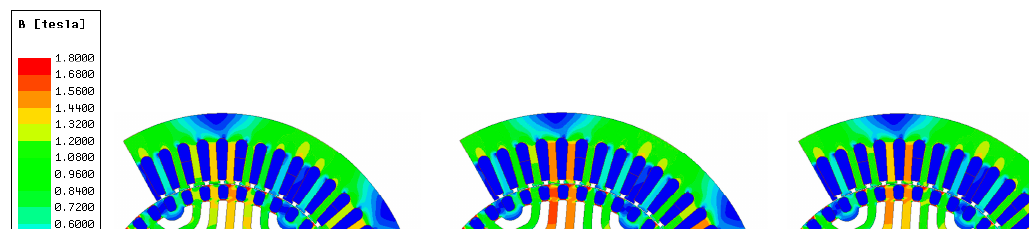
Figure 7. FEA model for analysis according to the position of magnet in ( a ) model 1, ( b ) model 2, and ( c ) model 3 .